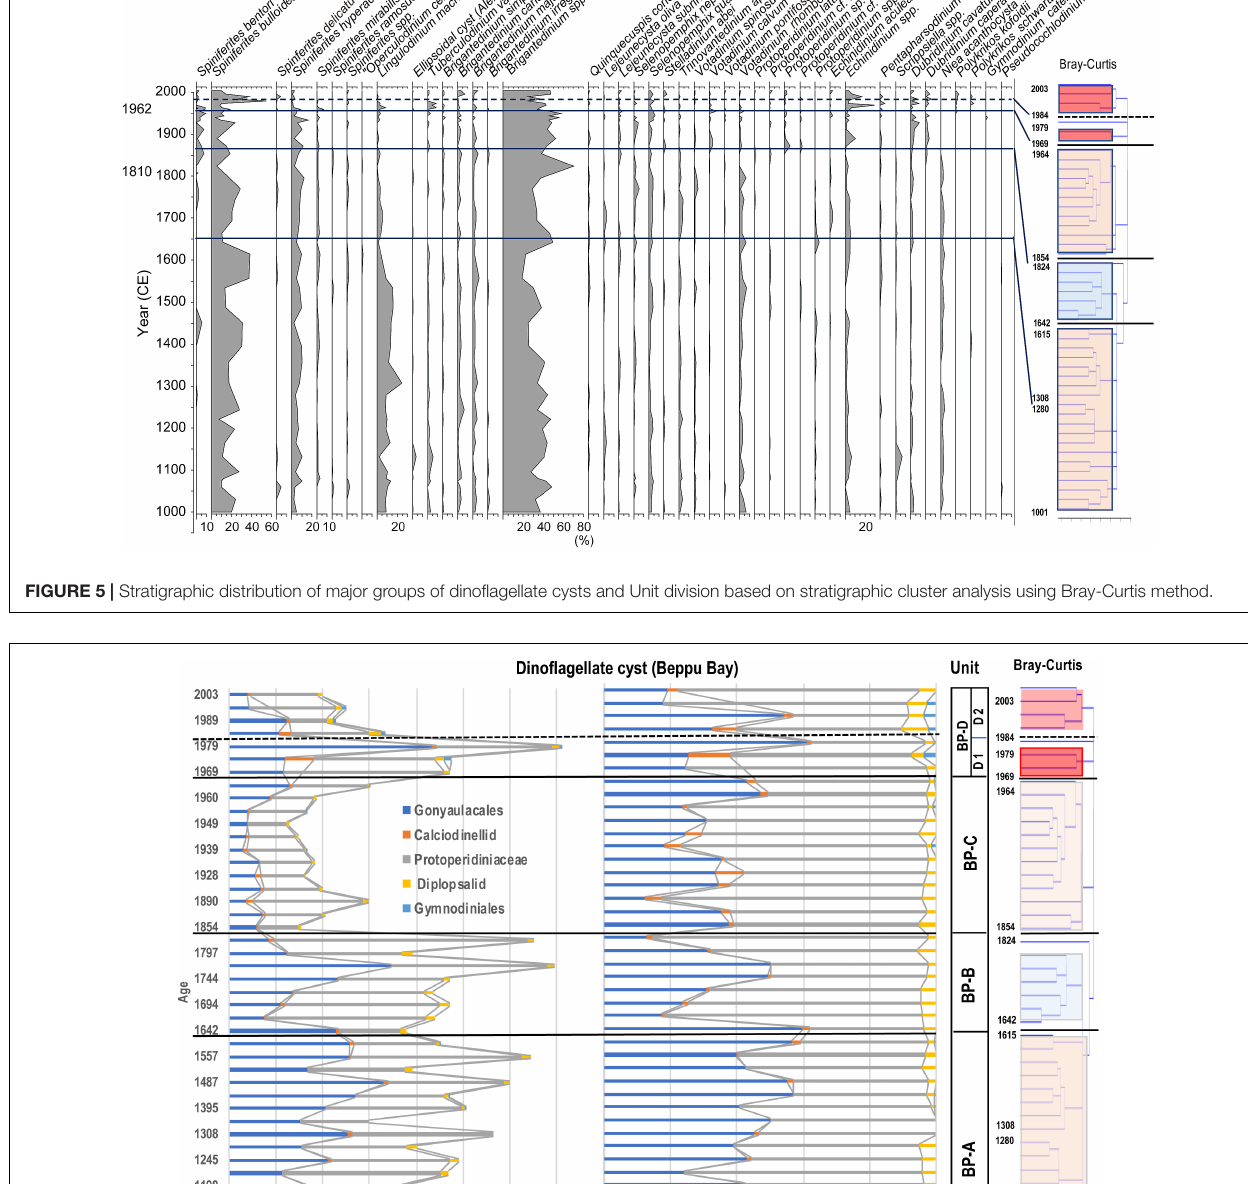
However, their occurrence patterns were different from those of dinoflagellate cysts and microforaminiferal linings. Until year 1665, the output was almost constant (615 eggs/g on average),